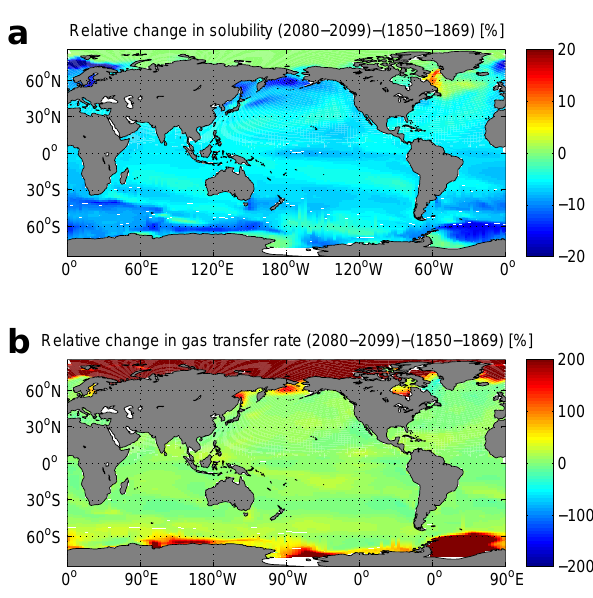
Fig. 11. Change in CO 2 gas solubility and gas transfer rate for the 2080–2099 period relative to the pre-industrial period simulated in the COU. Units are in